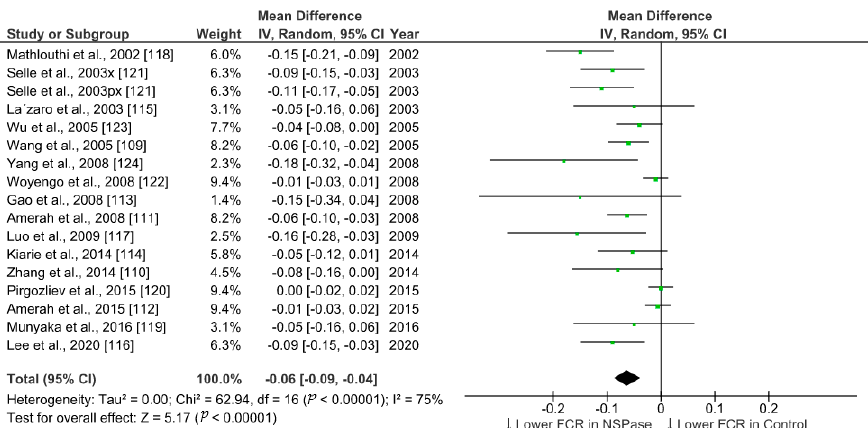
Figure 2. Forest plot of comparison: Effect of non-starch polysaccharides degrading enzymes on feed conversion ratio in broilers fed either wheat or barley or rye-based diets during a trial duration of 20–25 days. Abbreviations: FCR: feed con- version ratio; px: phytase + xylanase; x: xylanase; IV: inverse-variance; CI: confidence interval; Tau 2 : tau-squared; Chi 2 : chi-squared; df: degrees of freedom; I 2 : I-squared statistic; Z: Z-test statistic. The vertical line corresponding to the value of zero (0) in the plot is the line of no effect. The hyphen (-) represents a negative mean difference (effect size) and corre- sponds to a lower feed conversion ratio in NSPase group compared with control. The squared green boxes represent the point estimates and the width of the horizontal lines extending from the squared green boxes represent the 95% confidence interval of the individual study. The mid-point of the green boxes represents the mean effect estimate and the area of the boxes represent the corresponding weight given to each study. The diamond at the bottom of the studies represents the summary estimate and confidence interval of all studies combined. The points on the vertical axis of the diamond represents the overall effect and the width of the diamond represents the 95% confidence interval. The downward arrow in the label of the plot visually represents a lower feed conversion